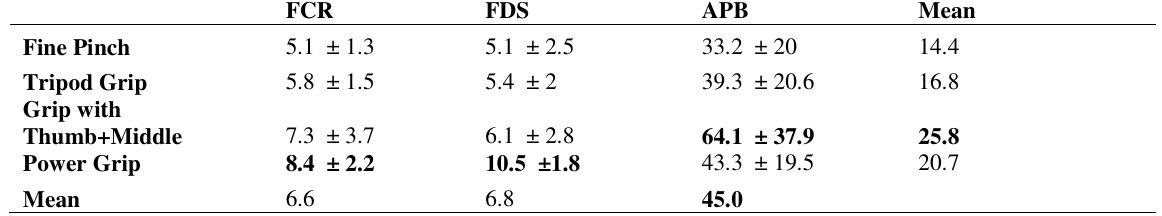
Mean values of EMG activity (mean ± SD) in in ( µ V) of different grips types for the case of 10% MVC for 5 subjects for FCR, FDS and APB